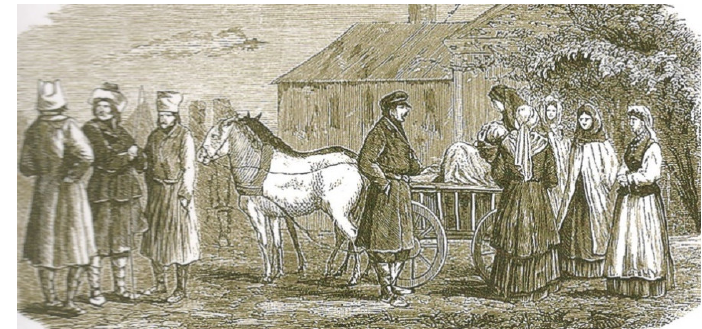
Figure 3. Lithuanians from the Ukmergė district [54].